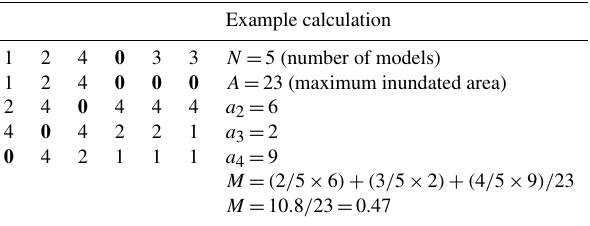
Table 3. M (MAI) calculation based on an example grid with a river indicated in bold with a value of